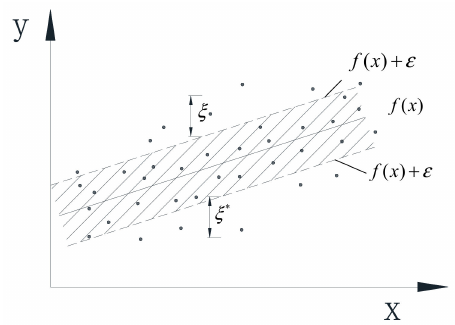
Figure 2. Schematic of the ε -insensitive loss